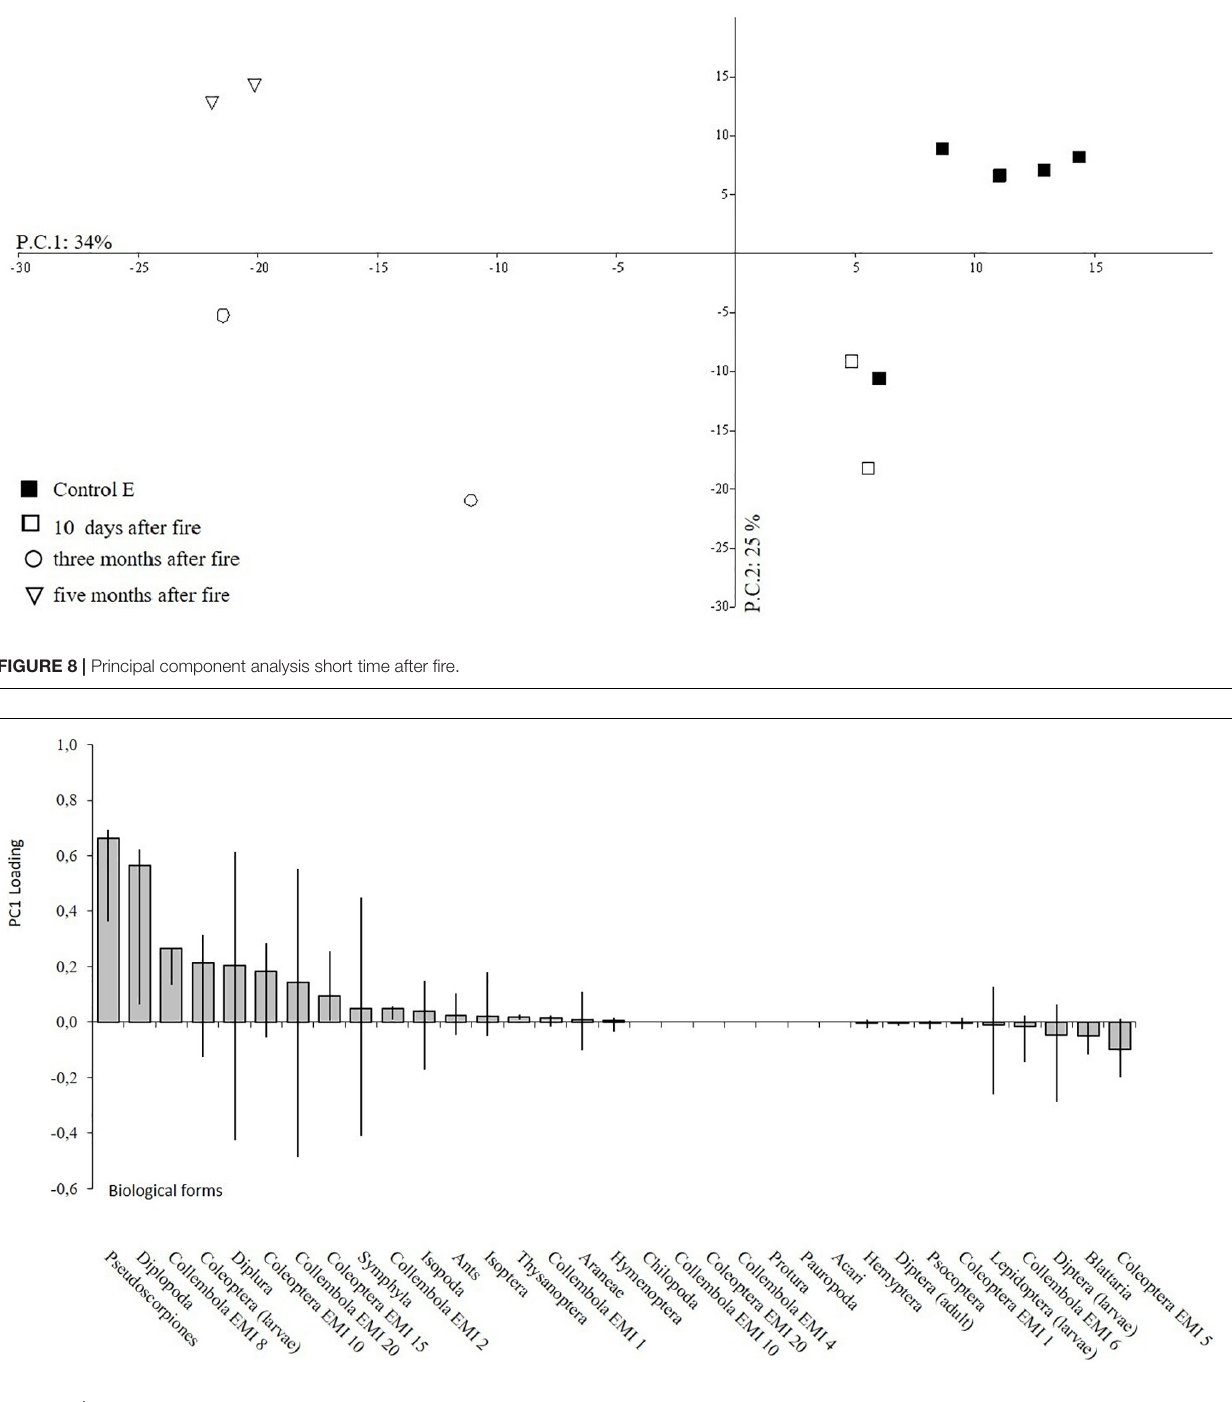
FIGURE 9 | PC1 factor loadings. The line represents the 95% bootstrap confidential interval of coefficient